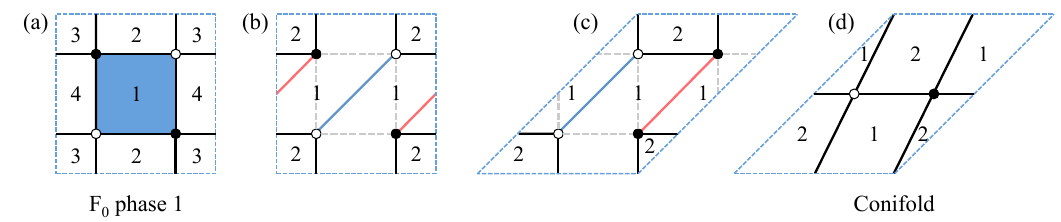
Figure 14. Instanton backreaction from phase 1 of F 0 to the conifold.